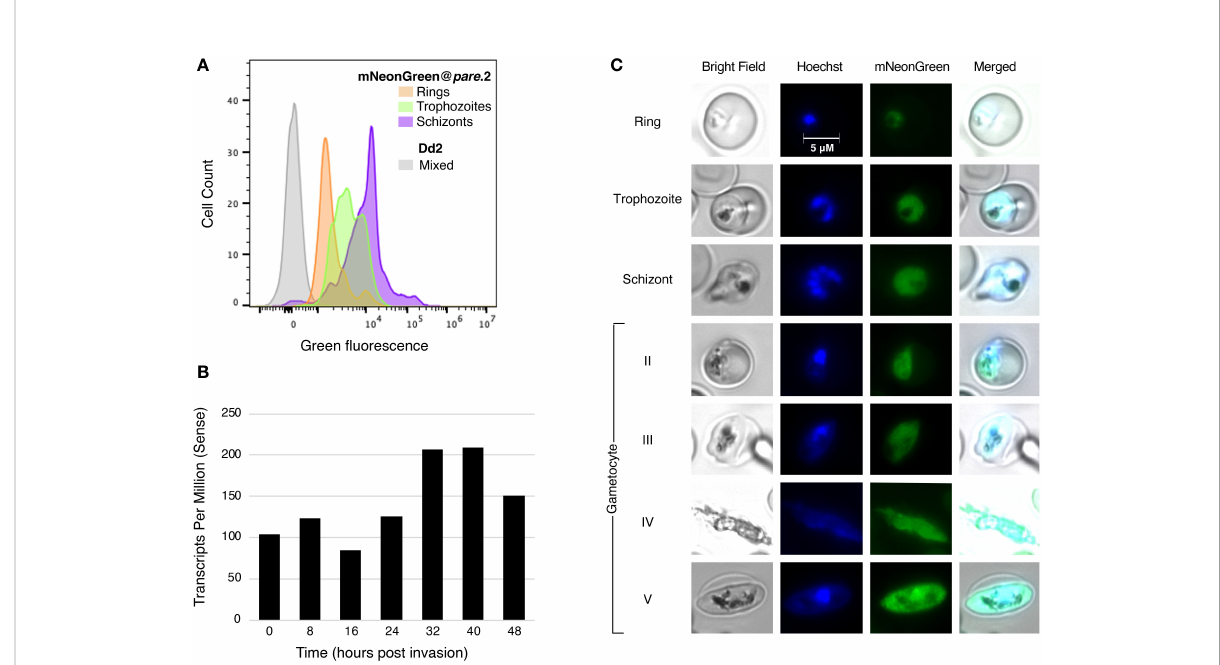
FIGURE 3 mNeonGreen@ pare fl uorescence varies between different asexual blood stages. (A) mNeonGreen@ pare. 2 parasites were sorbitol-synchronised and microscopy was used to con fi rm stages. Flow cytometry with MitoTracker DeepRed was used to enumerate parasites expressing green fl uorescence in ring, trophozoite and schizont-staged cultures. FlowJo was used to gate single-cell, parasitised RBCs, quantify green fl uorescence, and generate histograms. mNeonGreen@ pare schizonts demonstrated the greatest fl uorescence followed by trophozoites and then rings. (B) Stage-speci fi c RNA- sequencing obtained from PlasmoDB shows that pfpare is expressed throughout the entire 48hr intraerythrocytic life cycle and expression peaks at late trophozoite and schizont stages (Chappell et al., 2020; Amos et al., 2021). (C) Fluorescence microscopy of synchronised mNeonGreen@ pare parasites at asexual ring, trophozoite and schizont stages, and at gametocyte stages II-V (obtained through gametocytogenesis induction). Cultures were fi xed, stained with Hoechst DNA stain, and visualised using bright- fi eld and fl uorescence microscopy at 1000x magni fi